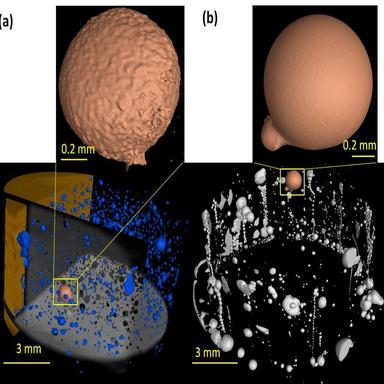
(a) Entrapped mercury drops in P03-30 sample with a magnified mercury drop of rough surface, and (b) mercury drops released from the same sample after MIP with a magnified mercury drop of smooth surface.